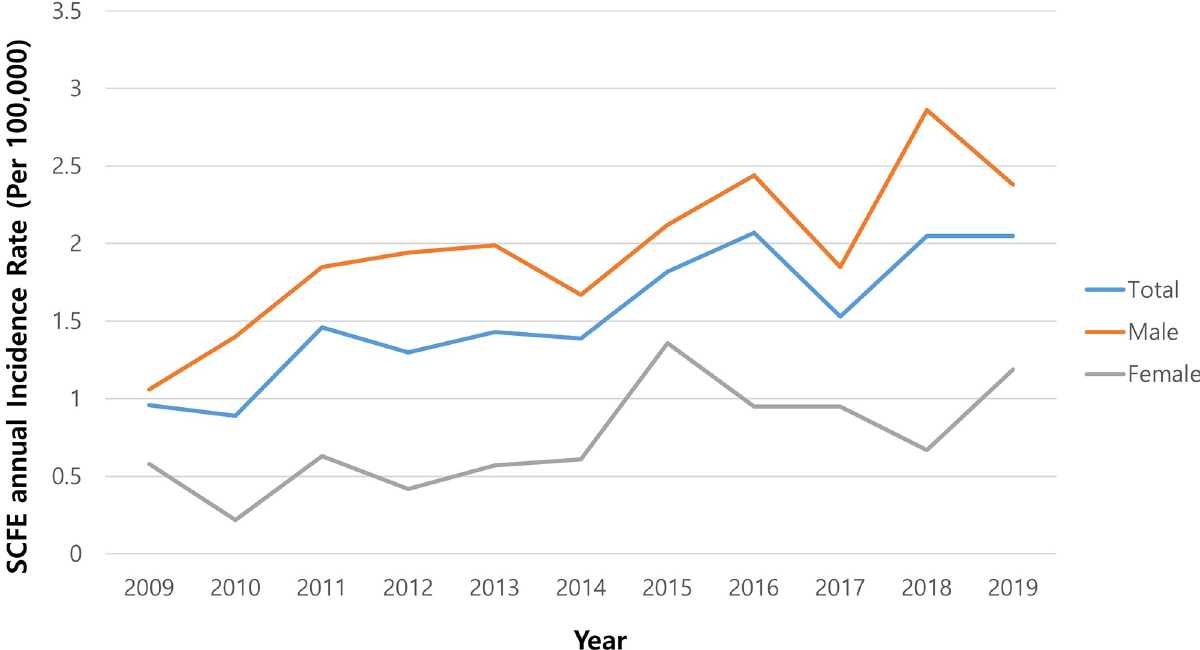
Fig 2. Annual incidence rate for slipped capital femoral epiphysis in children aged 9–14 years. https://doi.org/10.1371/journal.pone.0283123.g002 63%) was the most common comorbidity followed by pituitary disease (29 patients, 30%; Table 1).